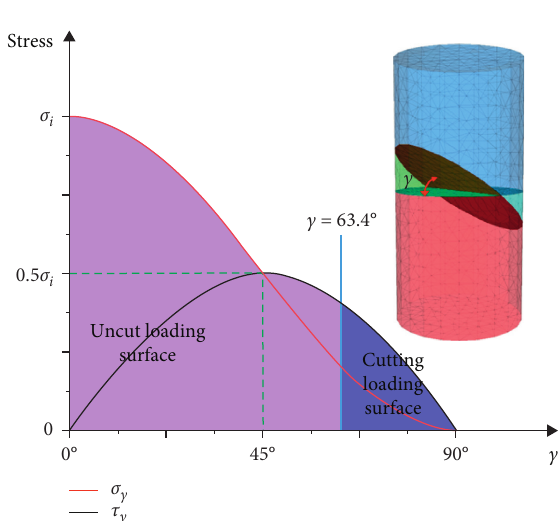
c and τ c with c .